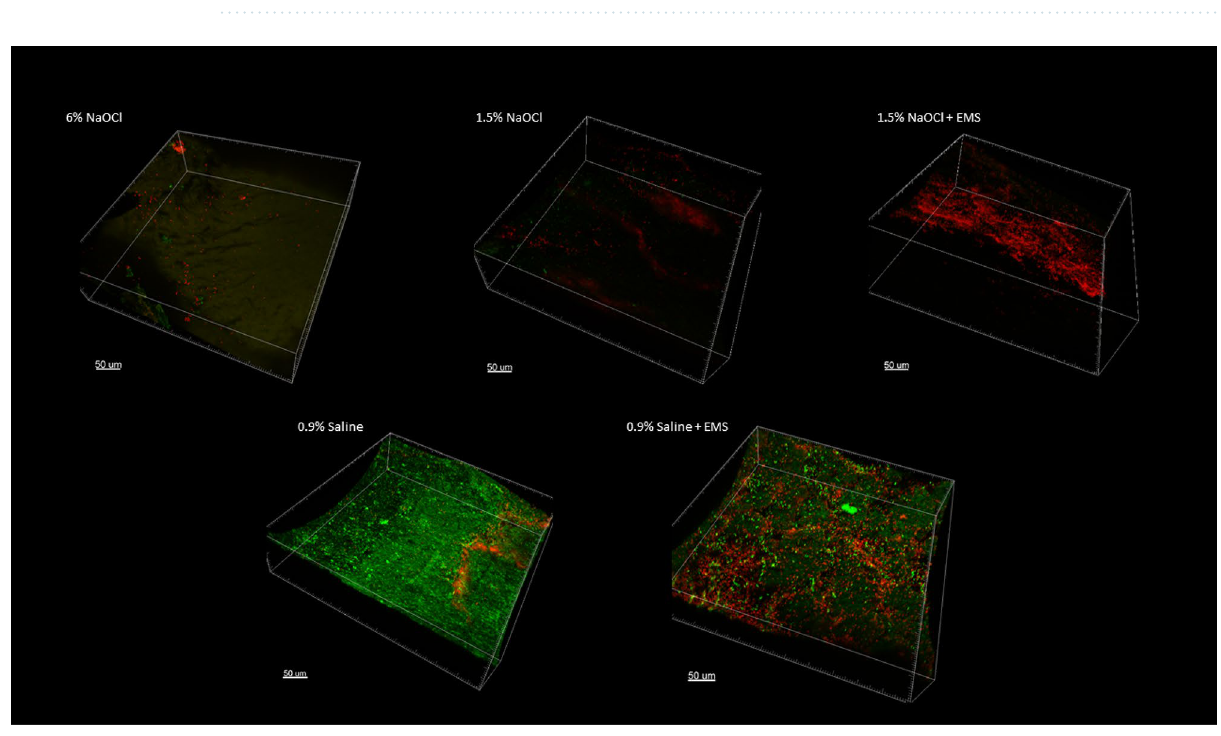
Figure 4. Apical 0–0.5 mm confocal images.